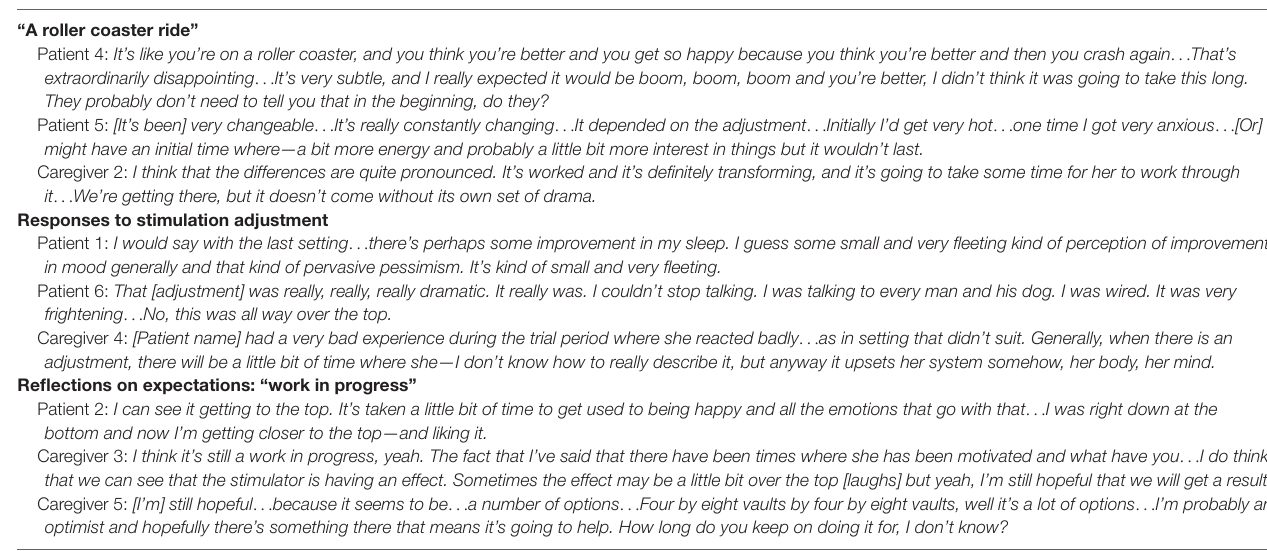
TABLE 3b | Anticipated vs. actual